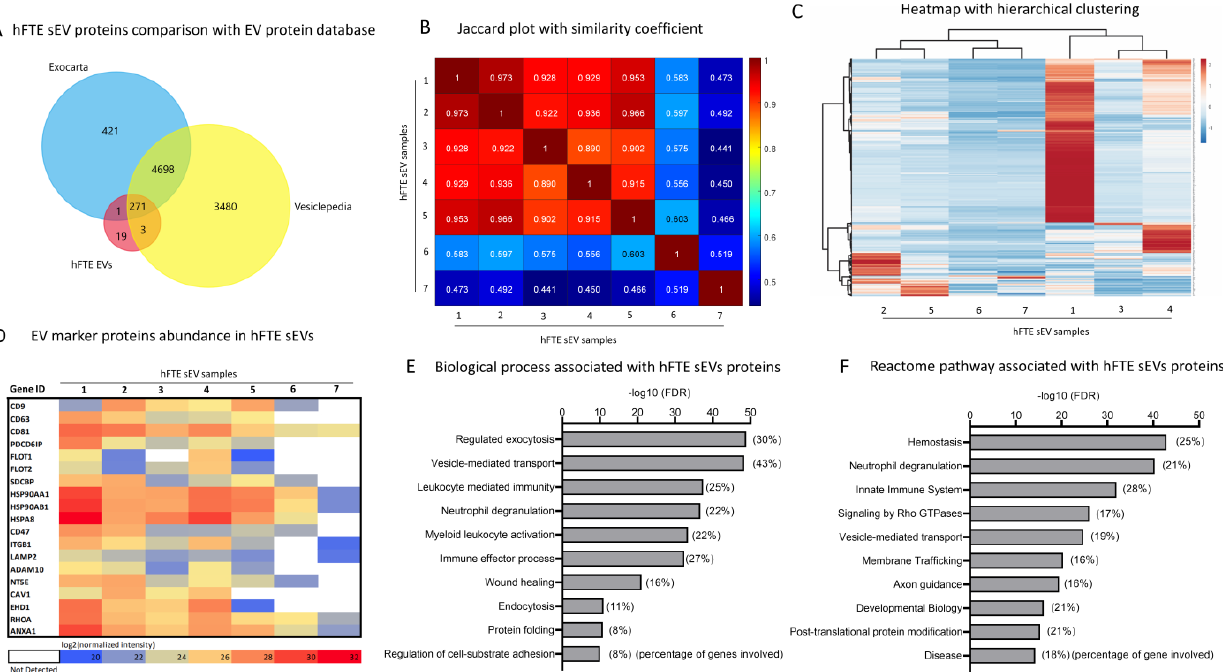
Figure 3. The proteomics characterization of sEVs derived from hFTE cultured in the PREDICT − MOS. ( A ) The comparison of 295 common proteins identified in at least five of seven hFTE sEV samples, with established EV protein databases, Vesiclepedia and Exocarta, showing 275 common proteins and 19 unique proteins. ( B ) The plot referring to the Jaccard index (or similarity coefficient), assessing the similarity in terms of the number of expressed proteins among seven samples based on 295 proteins. A Jaccard index of 1 (diagonal) indicates that the same proteins are expressed (100% similarity). A value of 0 for the Jaccard index would indicate no similarity corresponding to completely different sets of expressed proteins (no overlap or 0% similarity). ( C ) A heatmap demonstrating the protein abundance of 295 proteins among seven hFTE sEV samples. Rows are centered, and unit-variance scaling is applied to rows. Both rows and columns are clustered by Pearson’s correlation as a method, and Ward as a distance. ( D ) A heatmap showing the expression of proteins most frequently identified in EVs, based upon Vesiclepedia and Exocarta databases among seven hFTE sEVs samples. ( E , F ) Gene-enrichment analysis using GO biological processes and REACTOME pathway analysis, showing the biological processes and pathways associated with 295 hFTE sEV proteins. Inset in the figure represents the percentage of the genes responsible for a particular biological process.